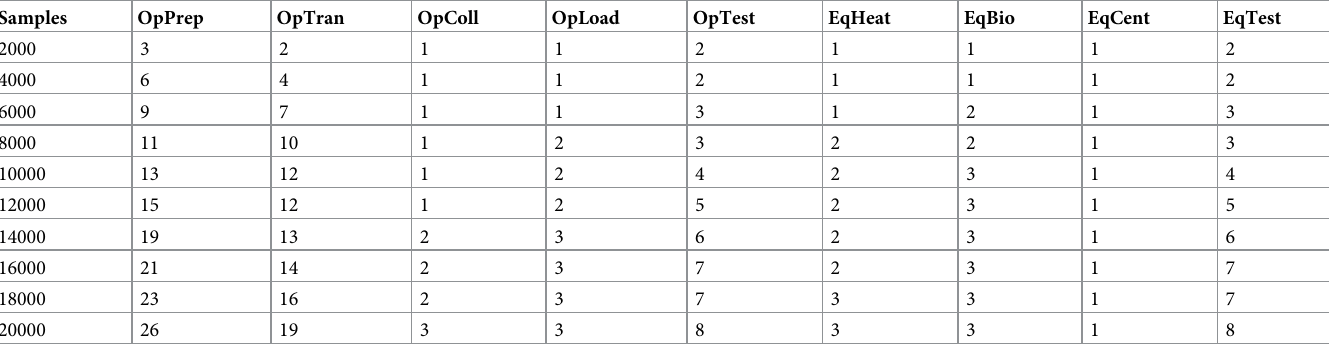
Table 3. Optimal resources allocation, as a function of the number of samples to be tested.